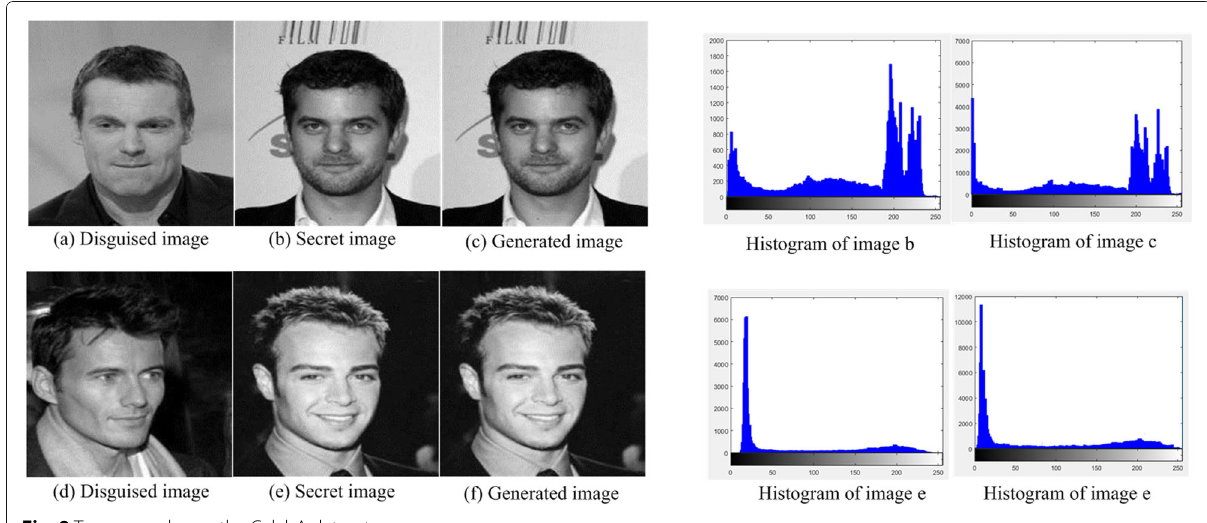
Fig. 8 Two examples on the CelabA dataset